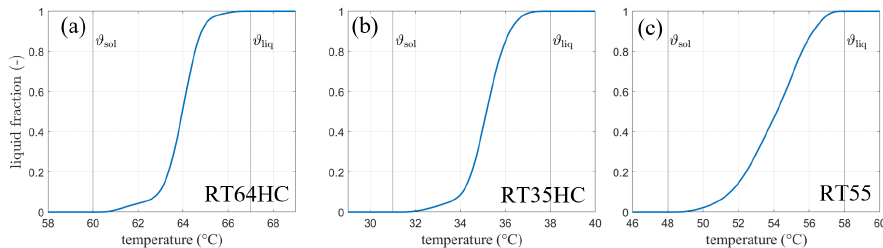
Figure 2. Phase fraction-temperature curves for the phase change material ( a ) RT64HC, ( b ) RT35HC and ( c ) RT55 (all from Rubitherm technologies)—(according to [13]).